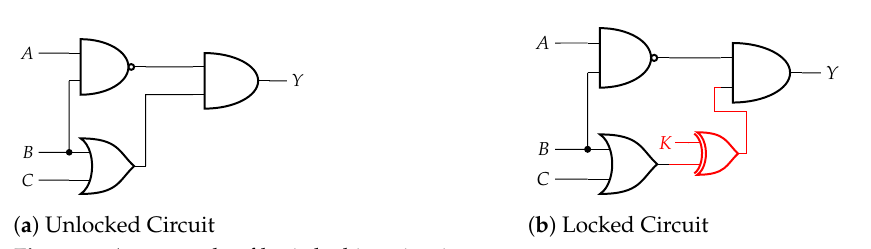
Figure 1. Logic Locking Overview.